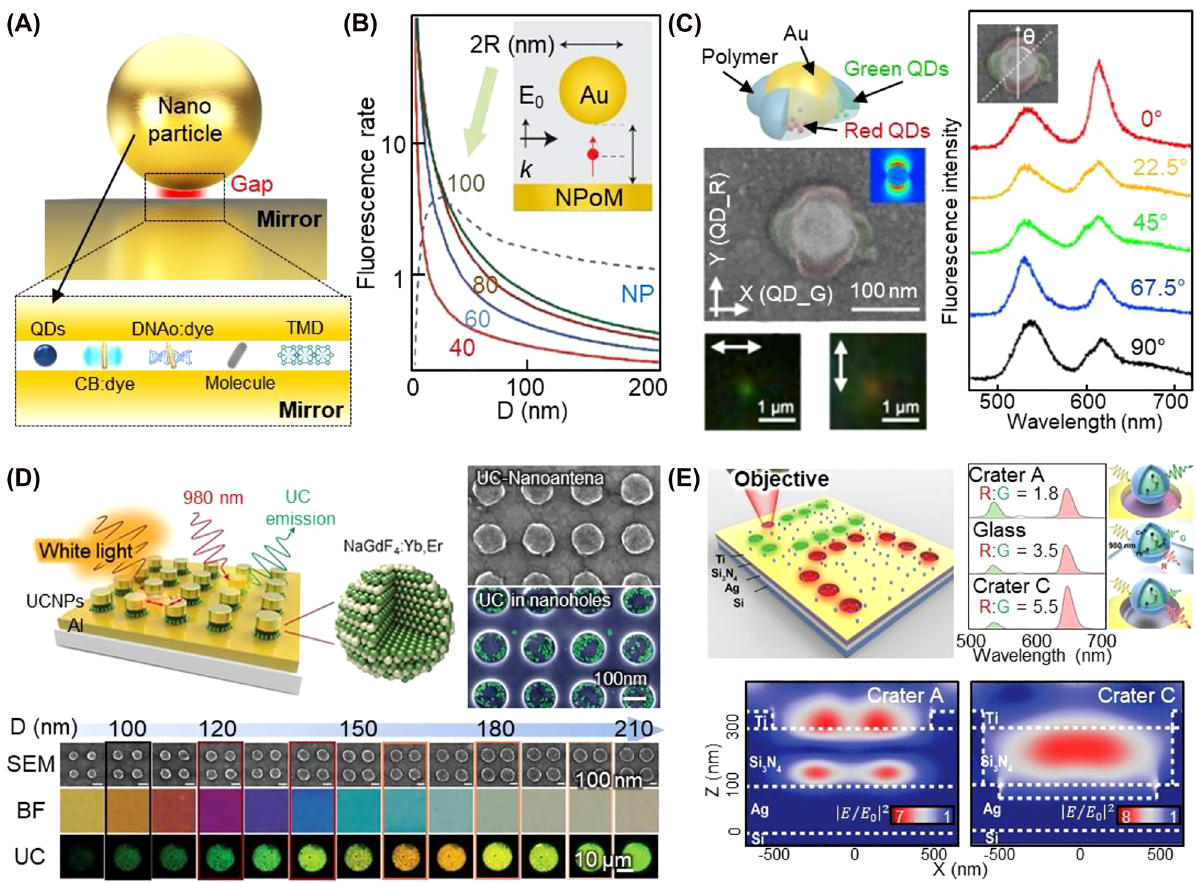
Figure 8: Hybrid plasmonic nanopixels with bandgap nanoparticles for the converted light coloration: (A) plasmonic nanoparticle-on-mirror construct with various emitters in the gap and (B) their associated optical near fi eld enhancement with emitter (reproduced with permission [134], Copyright 2018, American Chemical Society), (C) plasmonic nanoparticle orthogonally decorated with two different types of quantum dots (for red and green emissions) which independently excite the lights depending on the polarization of the light (reproduced with permission [195], Copyright 2015, American Chemical Society), (D) plasmonic nanoparticle-on-mirror construct and (E) nanohole-patterned plasmonic junctions fi lled with upconversion nanoparticles in their gaps (and holes) (reproduced with permission [191, 192], Copyright 2019, Wiley-VCH and 2019,